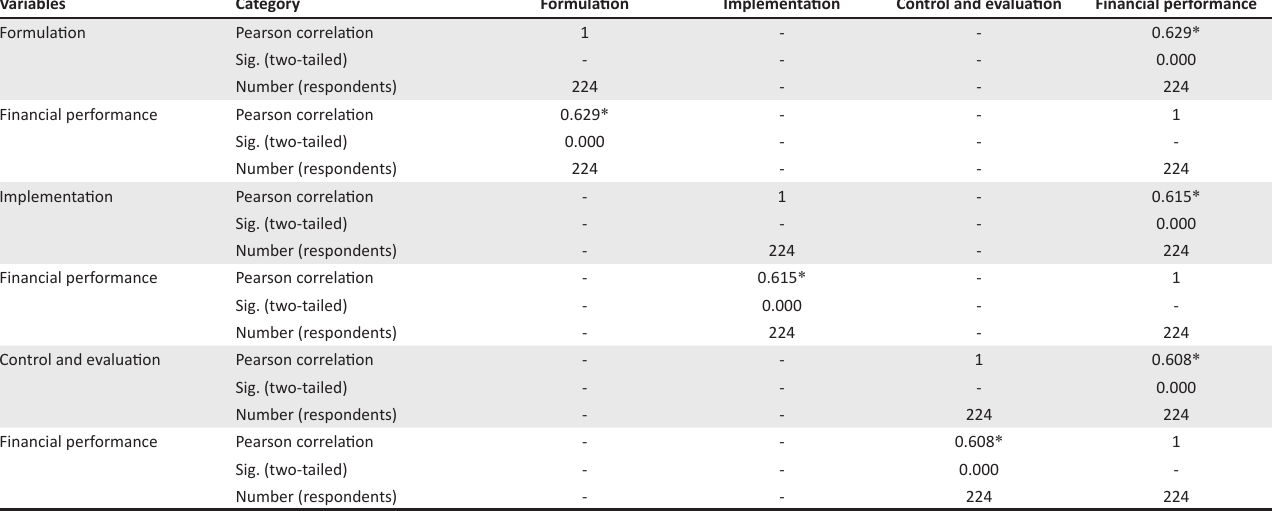
TABLE 3: Correlation